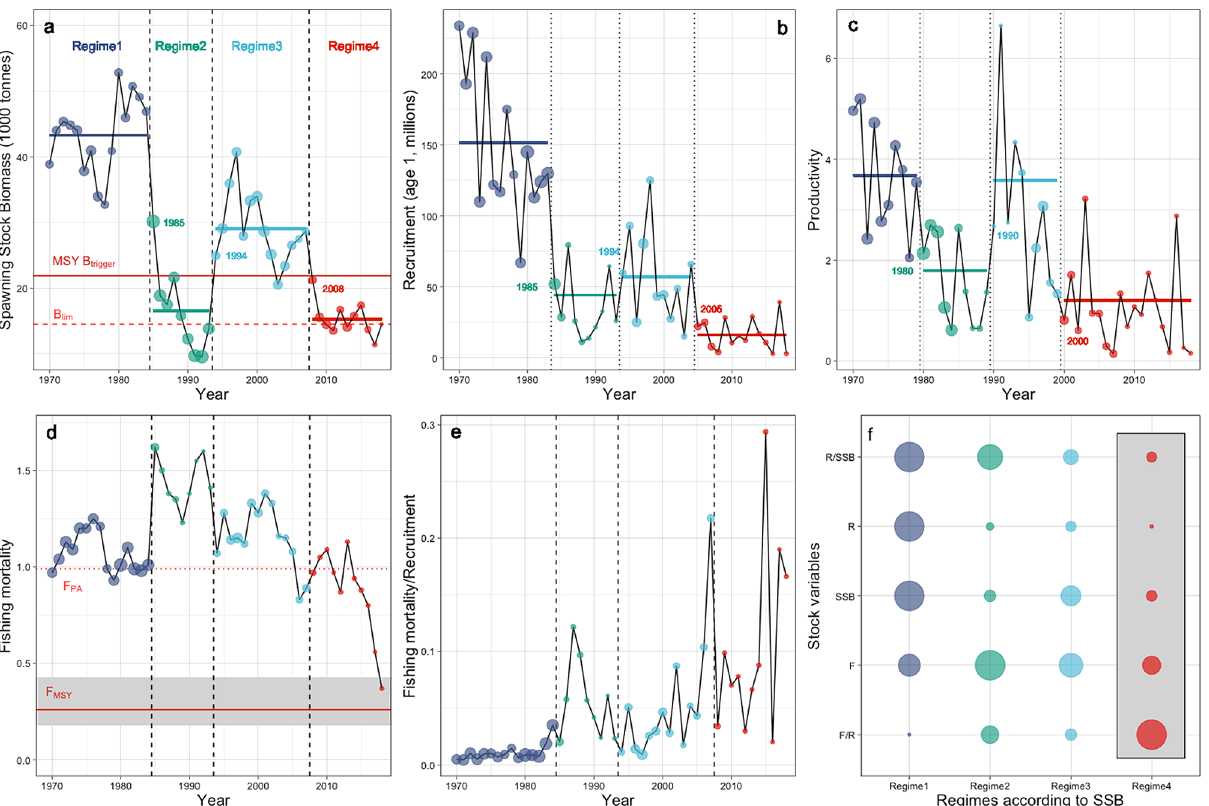
Figure 2. Abrupt changes and regimes in Western Baltic cod. ( a ) Spawning Stock Biomass (SSB); red solid horizontal line represent the biomass reference level MSY B trigger ; red dashed horizontal lines indicates biomass reference level B lim indicating danger of collapse; points size scaled to fishing mortality. ( b ) Recruitment (R) to the stock, i.e. year-class strength at age 1; point size scaled to SSB. ( c ) Productivity of the stock, i.e. R/SSB; point size scaled to SSB. ( d ) Fishing mortality (F); red solid horizontal lines indicate present F management target F MSY ; grey shaded area represents F management range; red dashed horizontal line indicates former precautionary F reference level F pa ; point size scaled to SSB ( e ) Fishing mortality relative to recruitment (F/R); point size scaled to SSB. ( f ) Summary of regime dynamics, point size represents mean of SSB regime periods (see Fig. 1a) with the highest value of a variable scaled to 1; grey shaded area represents recent Regime 4 (see Fig. 1a). Years in a-c indicate major changepoint years. Vertical and dashed lines indicate SSB regimes; vertical dotted lines indicate R regimes in b and R/SSB regimes in